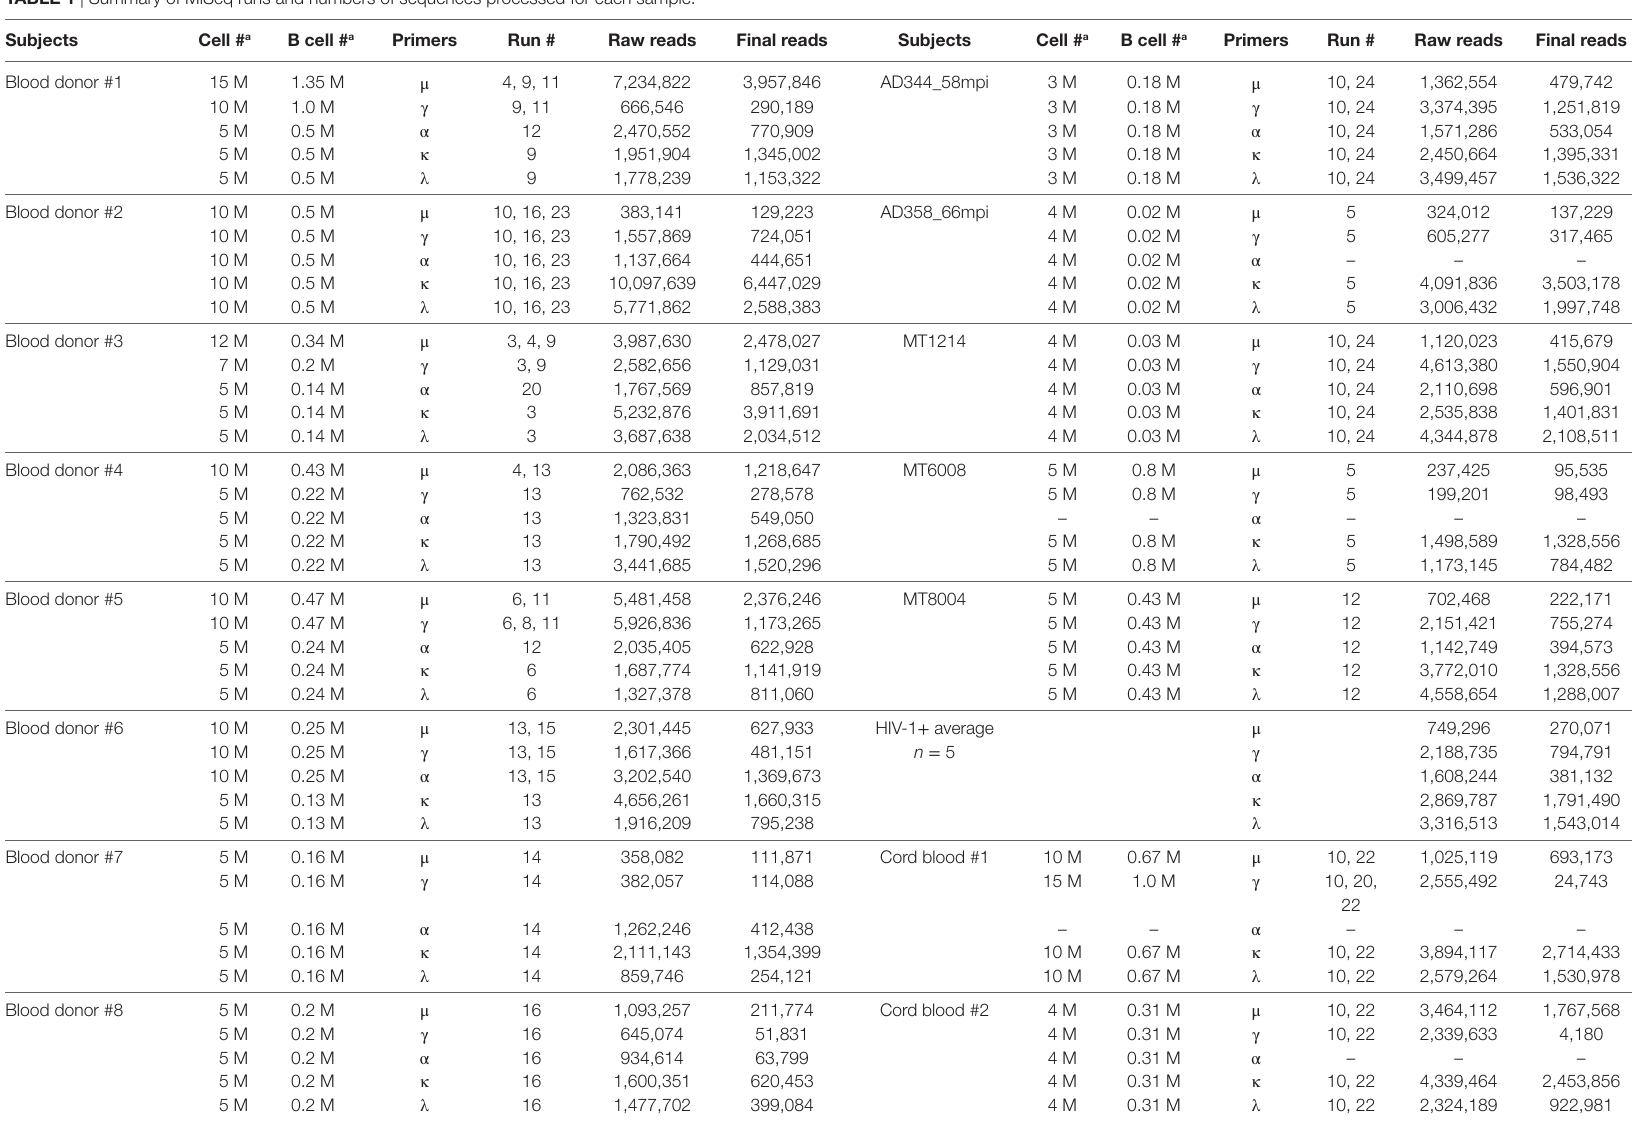
TaBle 1 | Summary of MiSeq runs and numbers of sequences processed for each sample.